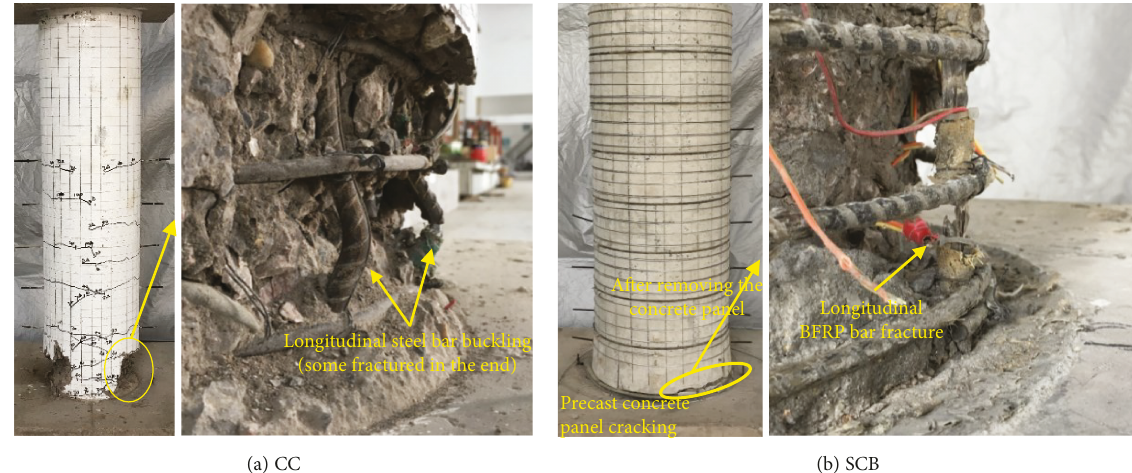
Figure 5: Failure mode of the